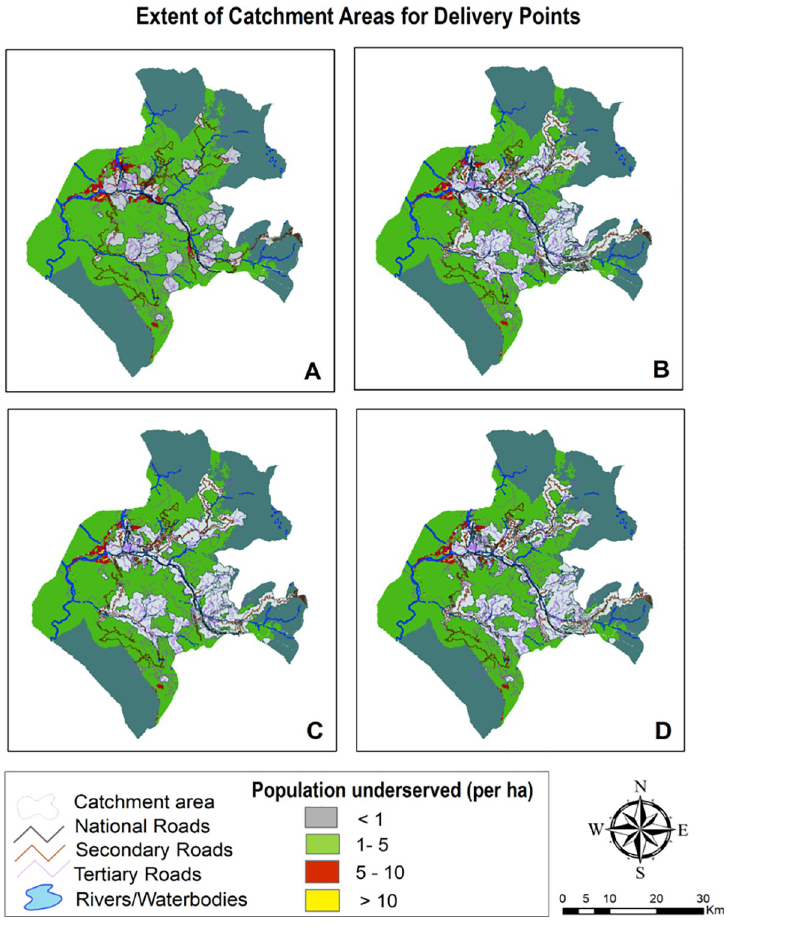
Fig 8. Mapping coverage for delivery care (2 hour travel